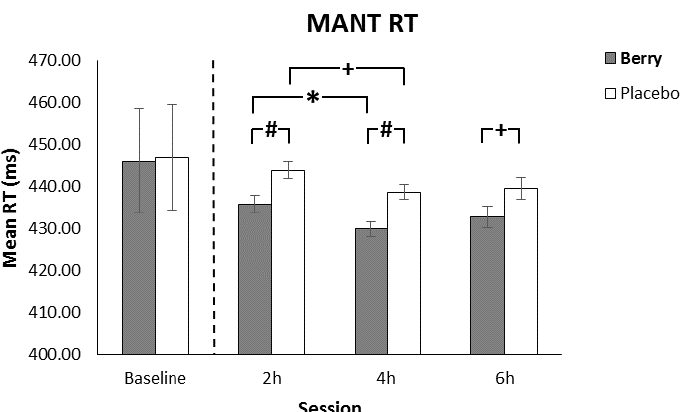
Figure 4. Reaction time ( ± SE of the mean) as a function of intervention and session, showing significantly faster berry performance at 2 and 4 h in comparison to the placebo and a significantly faster berry performance between 2 and 4 h. Note there was a trend towards significance at 6 h for faster berry performance in comparison to the placebo and a trend for faster placebo performance between 2 and 4 h. Baseline performance, included as a covariate in the analysis, is shown separated by the dotted line. + p < 0.1, * p < 0.05, # p < 0.01.